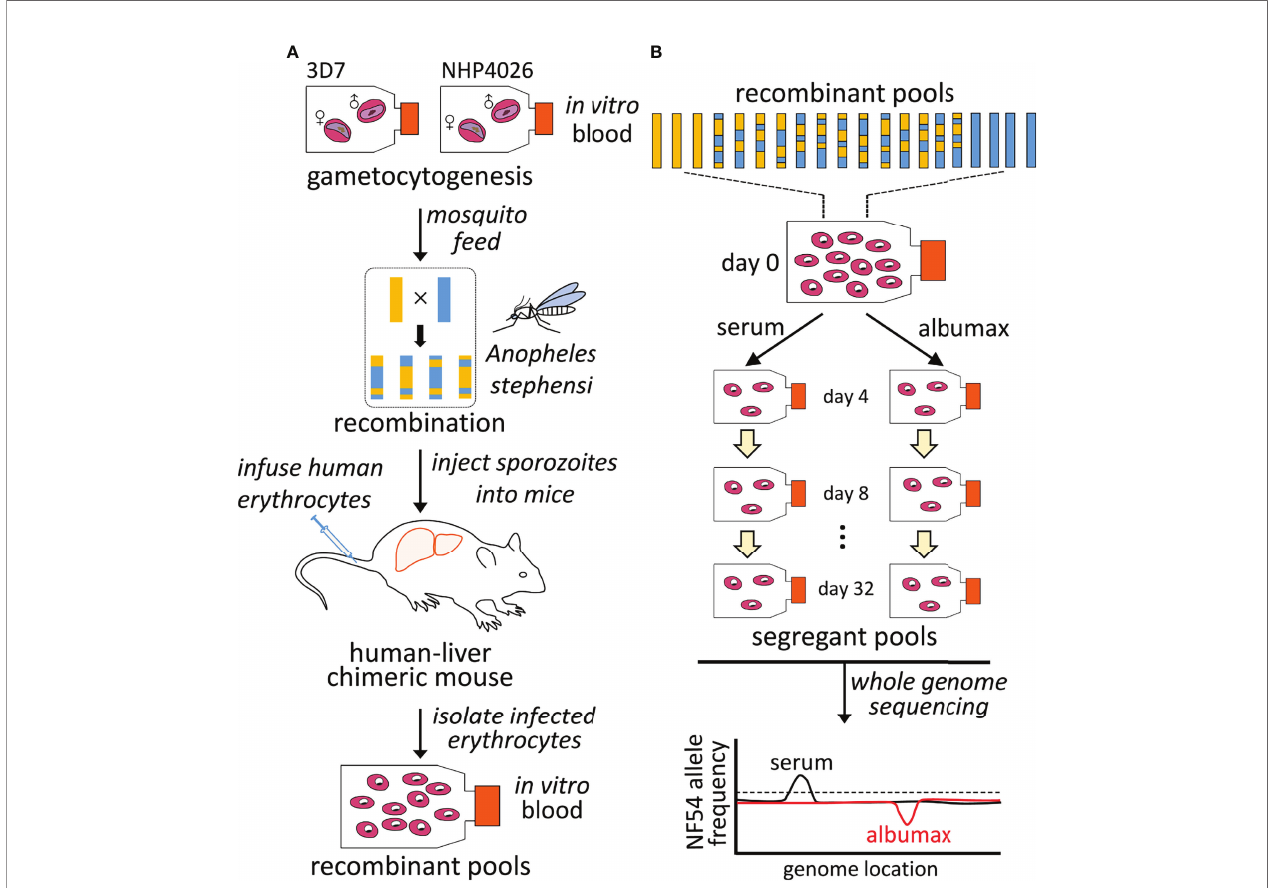
FIGURE 2 | Mapping parasite fi tness under different culture conditions. (A) . Recombinant progeny pool generation. Genetic crosses were generated using female Anopheles stephensi mosquitoes and FRG huHep mice as described by Vaughan, 2015. Recombination of parasite genomes occurs during meiosis in the mosquito midgut. Recombinant pools were collected from infected mice and maintained in in vitro asexual blood stage culture. (B) . Bulk segregant analysis. Pools of progeny were cultured in parallel with serum or AlbuMAX and samples were collected every four days. Each segregant pool was then whole-genome sequenced and genotyped in bulk. Differences in allele frequency among different groups were used to identify